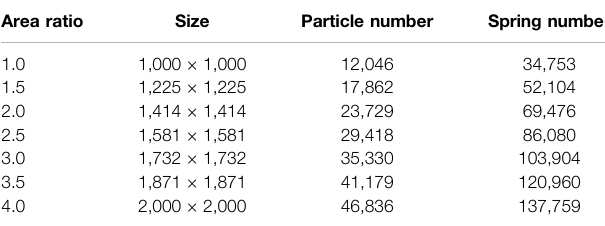
TABLE 2 | Model summary of Poisson